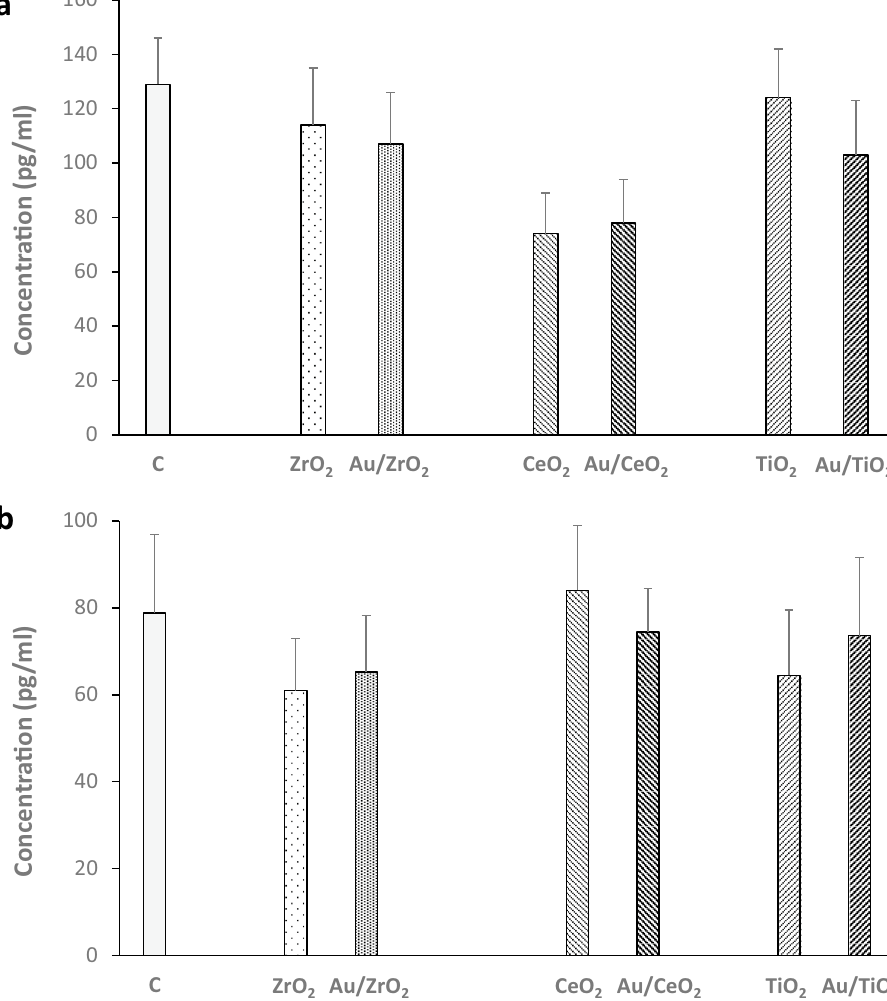
Figure 6. TNF-α and IL-1β adsorption on Au deposited on different MOx NPs. MOx or Au/MOx NPs (50 µg ml −1 ) were incubated during 6 h with TNF-α (150 pg ml −1 ) and IL-1β (100 pg ml −1 ) in culture media, then the cytokines were quantified in the media after